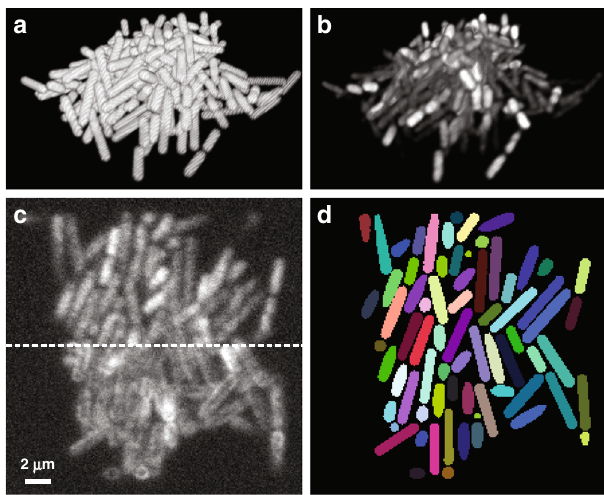
Fig. 1 Simulation of fl uorescent bio fi lms images and annotation maps used for CNN training. a Representative cell arrangements obtained by CellModeller. Due to the stochastic nature of bio fi lm growth, different cell arrangements are obtained in each new simulation. However, cell density is reproducible for each new simulated bio fi lm (typically N = 10 different bio fi lm simulations are used for CNN training, see “ Methods ” section). b Simulated 3D fl uorescence image based on the cell arrangements in a . c XY slice through the 3D simulated fl uorescence image in b (upper panel shows cells expressing cytosolic fl uorescent proteins, lower panel shows cells stained with membrane-intercalating dyes). d Ground truth cell arrangements giving rise to the image shown in c . Voxels are displayed as black (background), or in different colors (indicating different